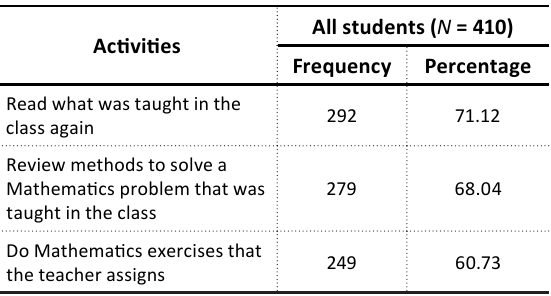
Table 5. Mathematics self-study activities